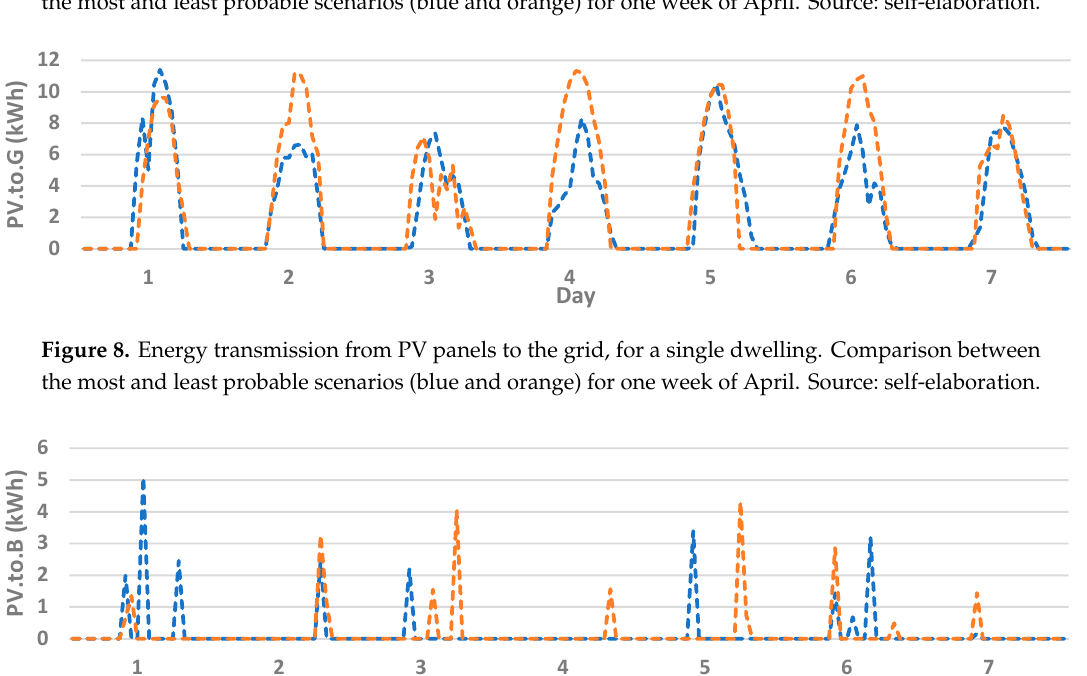
Figure 10. Energy transmission from the wind turbines to the battery bank. Comparison between the most and least probable scenarios (blue and orange) for one week (April). Source: self-elaboration. The sizing results lead the rated power of the wind systems to reach its upper limit; as a result, the wind system is able not only to charge the energy system but to sell the rest of the energy to the grid. As it is depicted in Figure 11, the energy management system forces the wind system to inject the surplus of energy to the grid in the night, when the lowest consumption happens while the wind speed is the highest. However, as PV and batteries have priority at supplying the loads, wind turbines’ contribution remains little, as Figure 12 shows. Figure 11. Energy transmission from wind turbines to the grid. Comparison between the most and least probable scenarios (blue and orange) for one week of April. Source: self-elaboration.